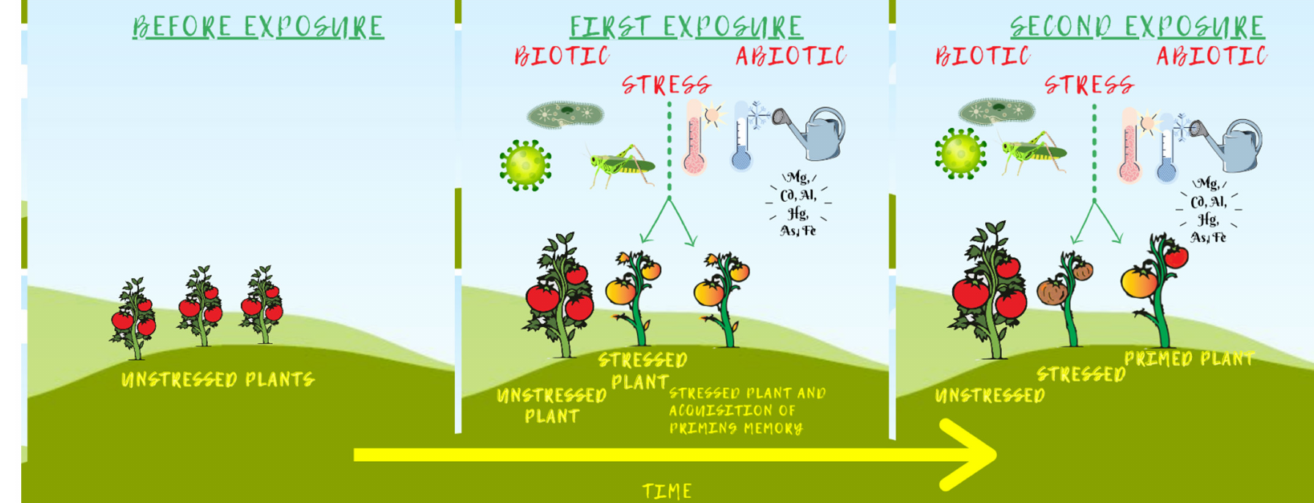
Figure 2. Intragenerational memory and priming in plants. Unstressed plants (tomato as an example of crop) are depicted on the left panel. One of them is shown growing over time in the other panels on the left with red healthy fruits. Stressed plants with the first exposure to biotic and/or biotic stimuli are shown on the middle panel with orange fruits and decreased size. The plant on the right developed an epigenetic response to stress, allowing the establishment of a priming memory. Stress is only temporary and is followed by a period of recovery (not shown). A second exposure to stress is shown on the right panel, with the primed plant (on the right) getting new red fruits and restart of growth compared to the prime plants (in the middle) exhibiting severe symptoms (brown